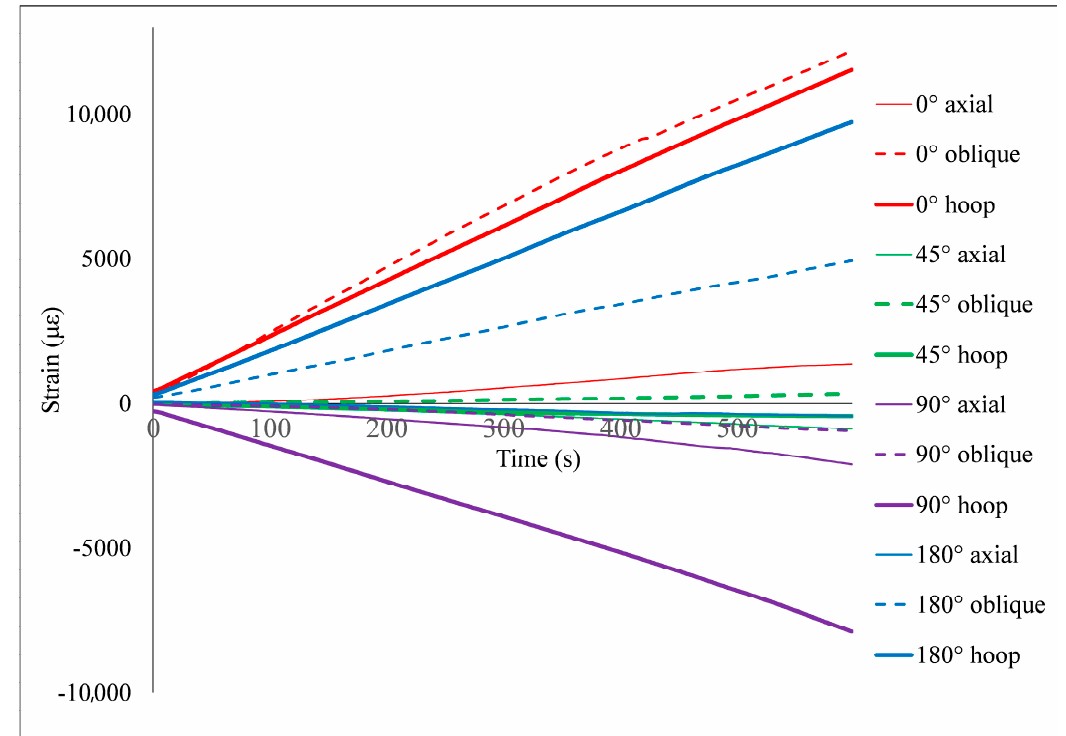
Figure 11. A typical strain-time curve for the plain type of DN400.